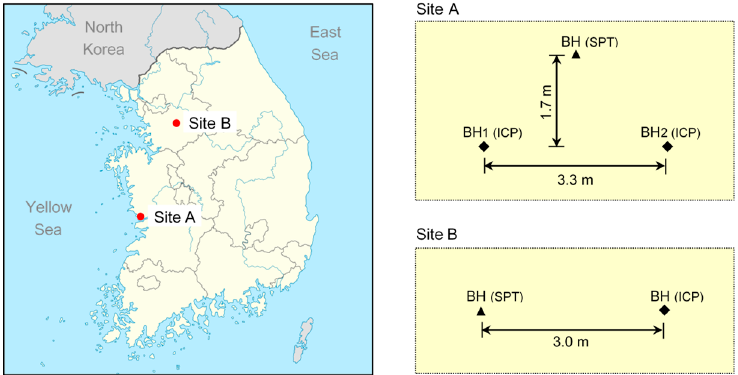
Figure 4. Location of sites and layout of the soundings in South Korea. BH—borehole.